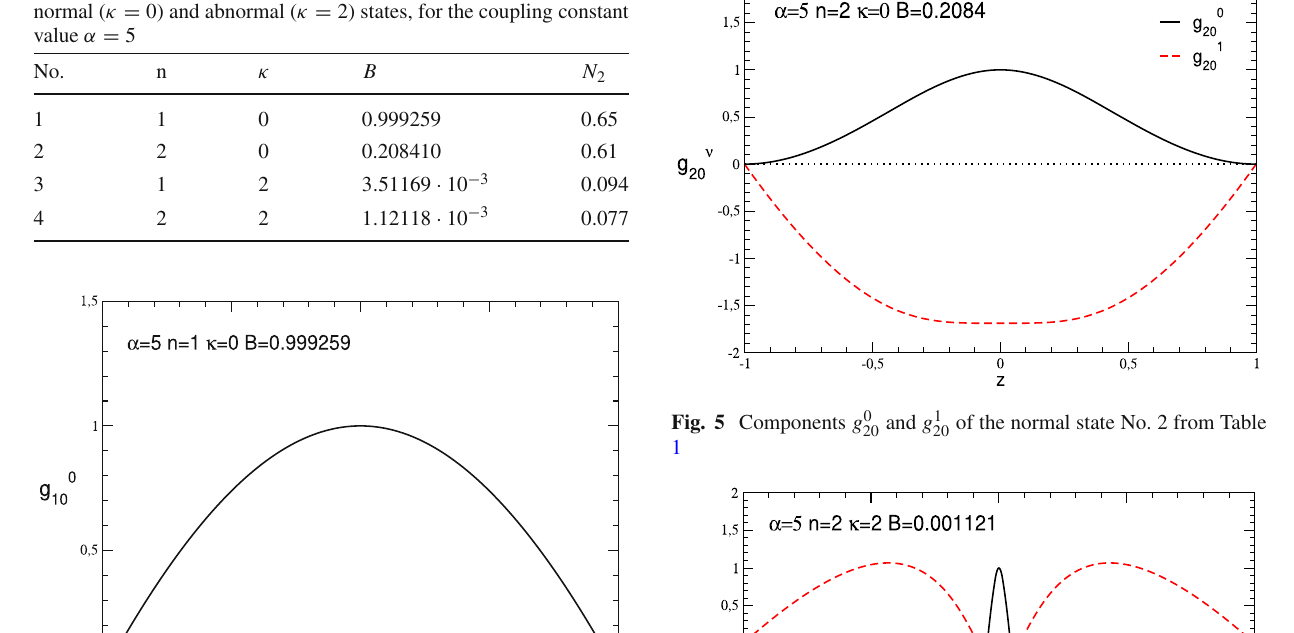
Table 1 Binding energy B and two-body norm ( N 2 ) of the low-lying normal ( κ = 0) and abnormal ( κ = 2) states, for the coupling constant